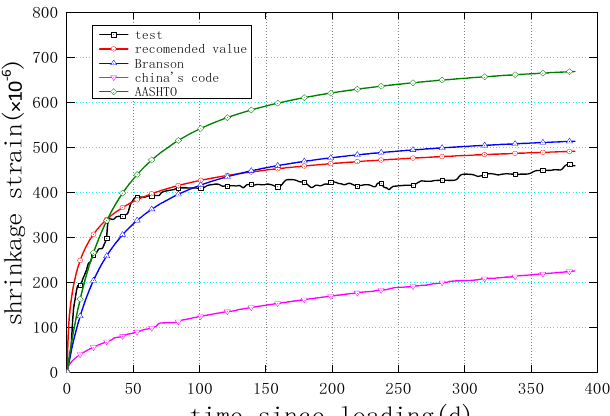
Figure 18. Shrinkage strain curves since loading based on AASHTO, Branson, Chinese code, the recommended, and tested value.